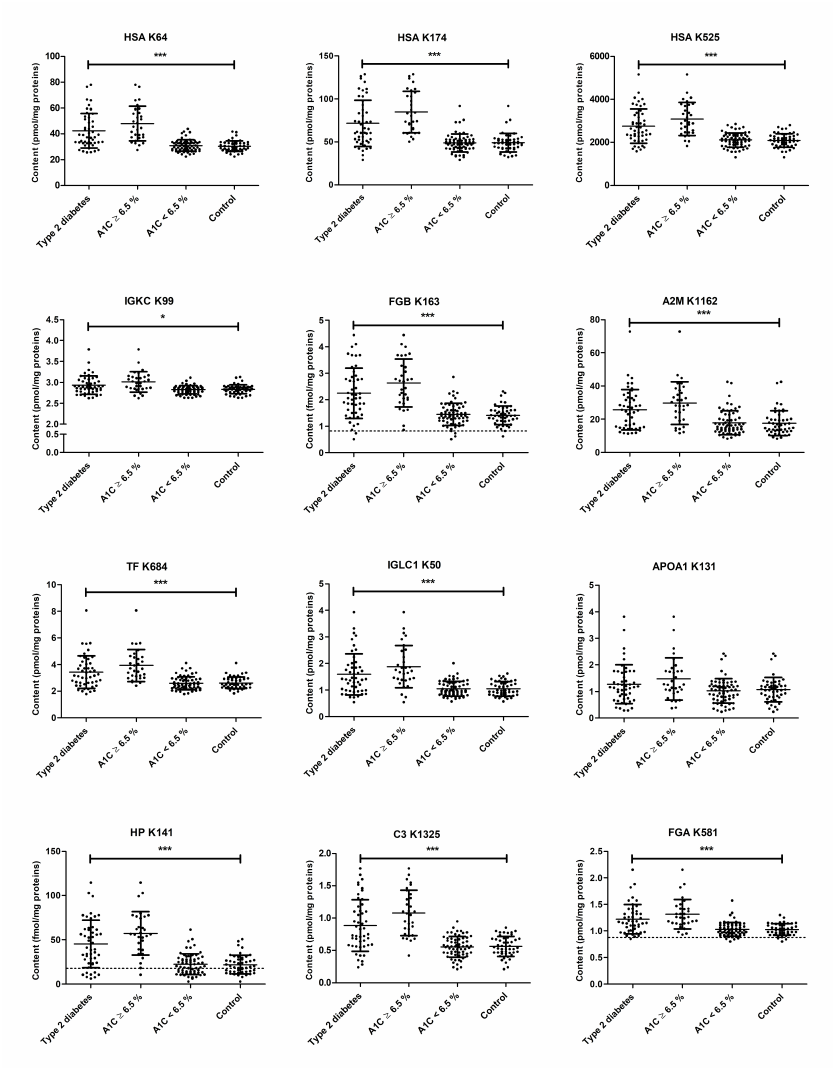
hemoglobin and the tested serum proteins correlated. Spearman’s rank correlation coefficients ( r S ), which were calculated for all glycated peptide levels and diagnostic parameters, ranged for most combinations of two glycated peptides from 0.37 to 0.98 ( p < 0.001, data not shown). Moderate to strong correlations were achieved for all glycation sites with FPG (28 sites, 0.35 < r S <0.70, p < 0.001), proinsulin (20 sites, 0.37 < r S < 0.54, p < 0.001), HOMA-IR (23 sites, 0.35 < r S < 0.62, p < 0.001), and HbA 1c values for most sites (0.42 < r S < 0.76) (Table S11). Nine of the 14 glycation sites studied here for HSA and one site of fibrinogen beta chain (FGB K163) moderately correlated with free fatty acids (FFAs, 0.36 < r S < 0.46, p < 0.001), whereas correlations between peptide glycation and BMI were weak ( − 0.16 < r S < 0.25, 0.03 < p < 0.98).